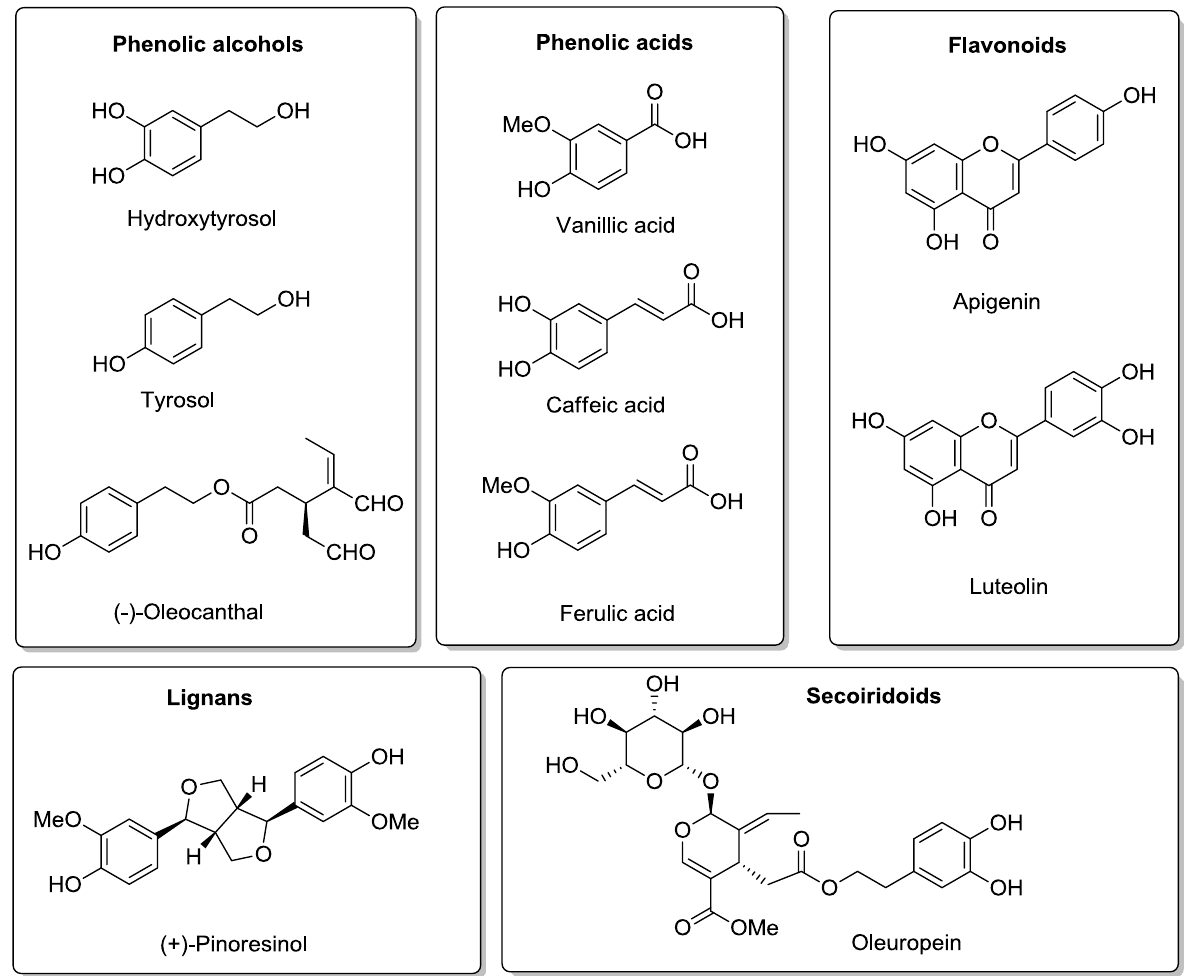
Figure 1. The different classes of polar phenolic compounds present in olive oil with molecular structures of representative